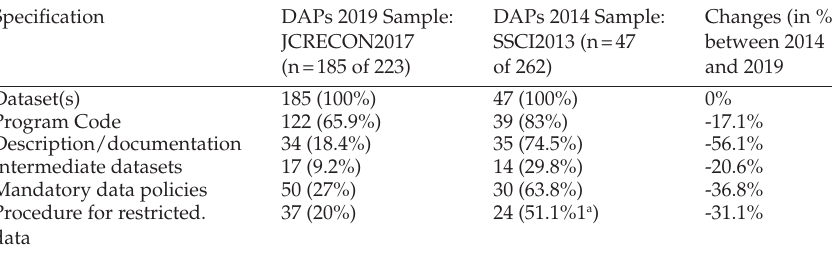
Table 3: Specifications and demands of data availability policies in 2014 and 2019 in